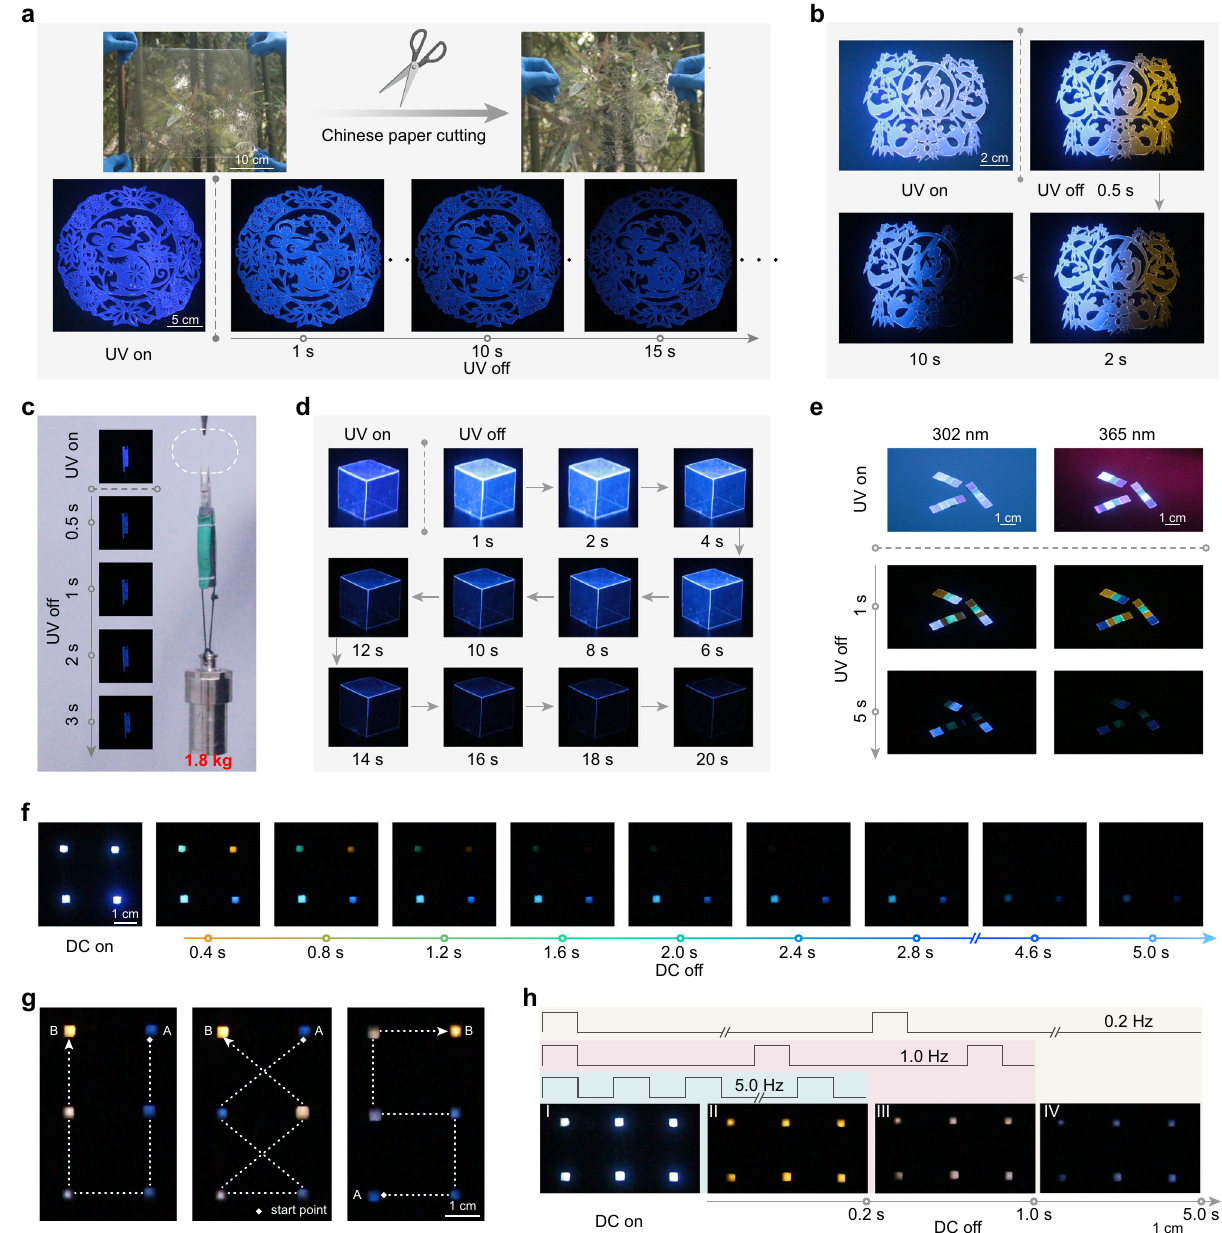
Fig. 5 | Description of UOP fi lms for afterglow display, anti-counterfeiting and visualfrequencydetectionunderambientconditions.a , b Transparentartcrafts with UOP feature by Chinese paper-cutting technology based on the fl exible fi lms containing one or two emitters. Inset: photographs of the art crafts taken under sunlight and a 302nm UV lamp as well as removal of the excitation, respectively. c Demonstrationofself-healingpropertyoftheCzA/PVA fi lm.Inset:photographsof the fi lm after self-healing taken under a 302nm UV lamp on/off. d Photographs of an emissive 3D cube (2×2×2cm 3 ) under a 302nm lamp on/off. e Ribbons